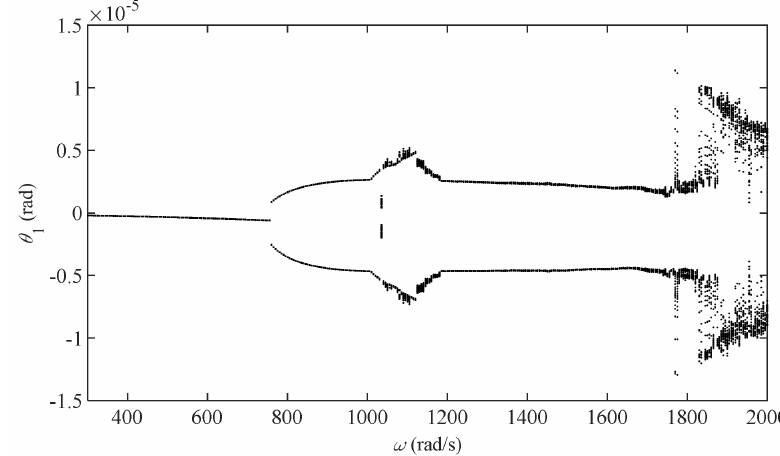
Figure 6. Bifurcation diagram of vibration response varying with